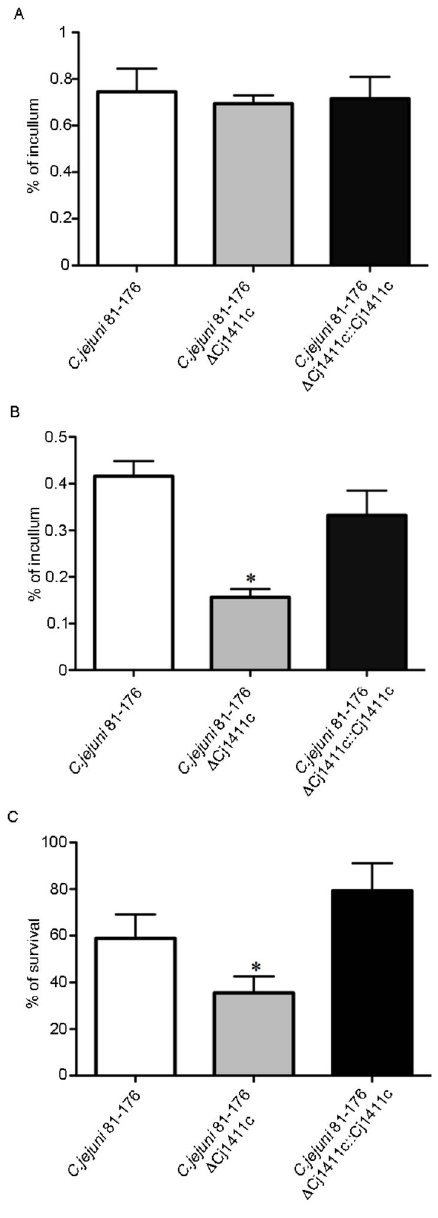
Figure 2. Virulence and serum resitance. (a) adhesion to HCT-8 cells, (b) invasion of HCT-8 cells of C. jejuni 81-176 wild type, C. jejuni 81-176 Δ Cj1411c and C. jejuni 81-176 Δ Cj1411c :: Cj1411c . (c) serum resistance - the survival rate is defined as the number of C. jejuni 81-176 colonies isolated following exposure to human serum divided by the number of colonies surviving in heat inactivated serum, expressed as a percentage. Statistical significance (Student’s t test) relative to the level of wild type strain is indicated. *P=0.001. The experiments were done in triplicate and on three separate occasions. The error bars represent standard deviations for six separate wells. doi: